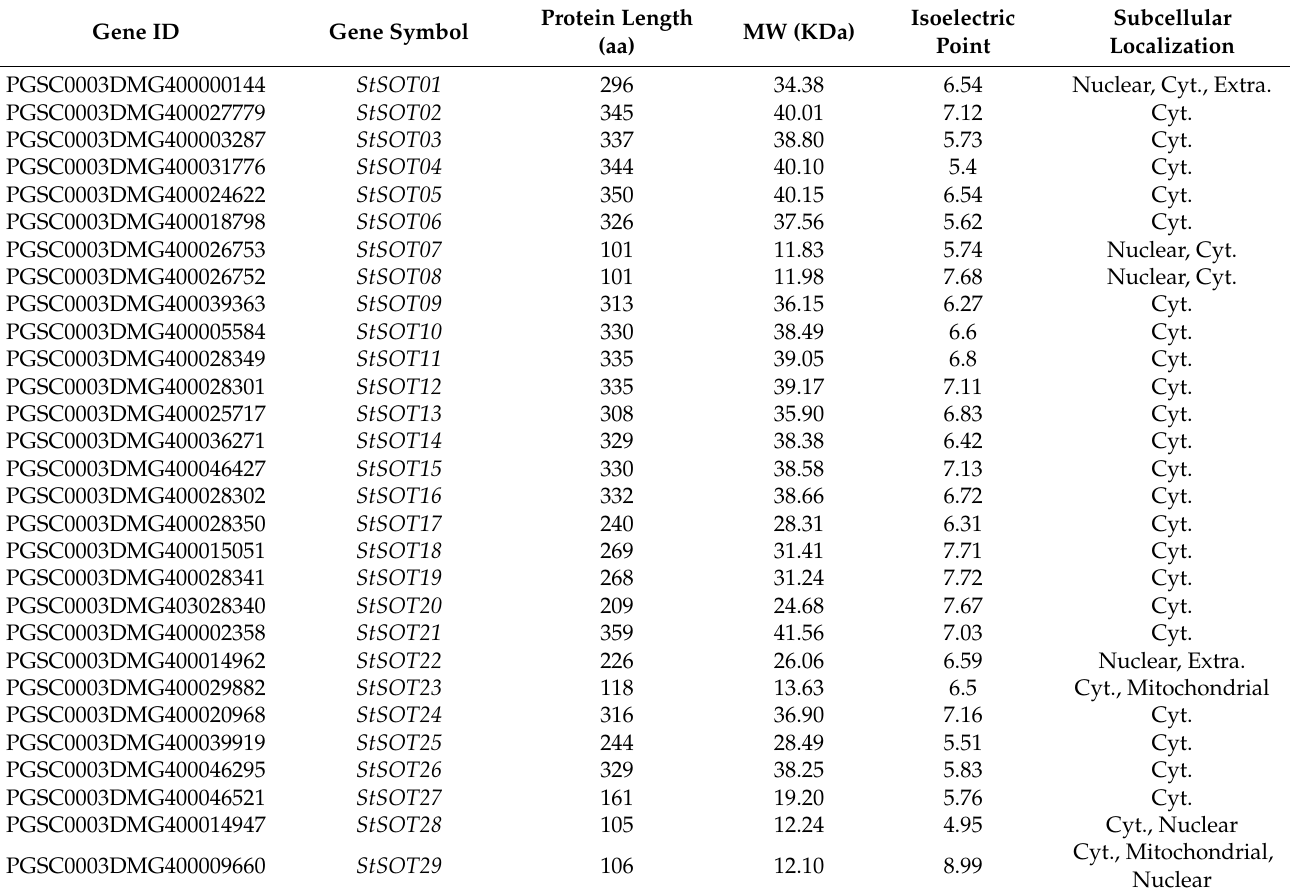
Table 1. Identified StSOT gene family members and their characteristics in the potato genome. Gene